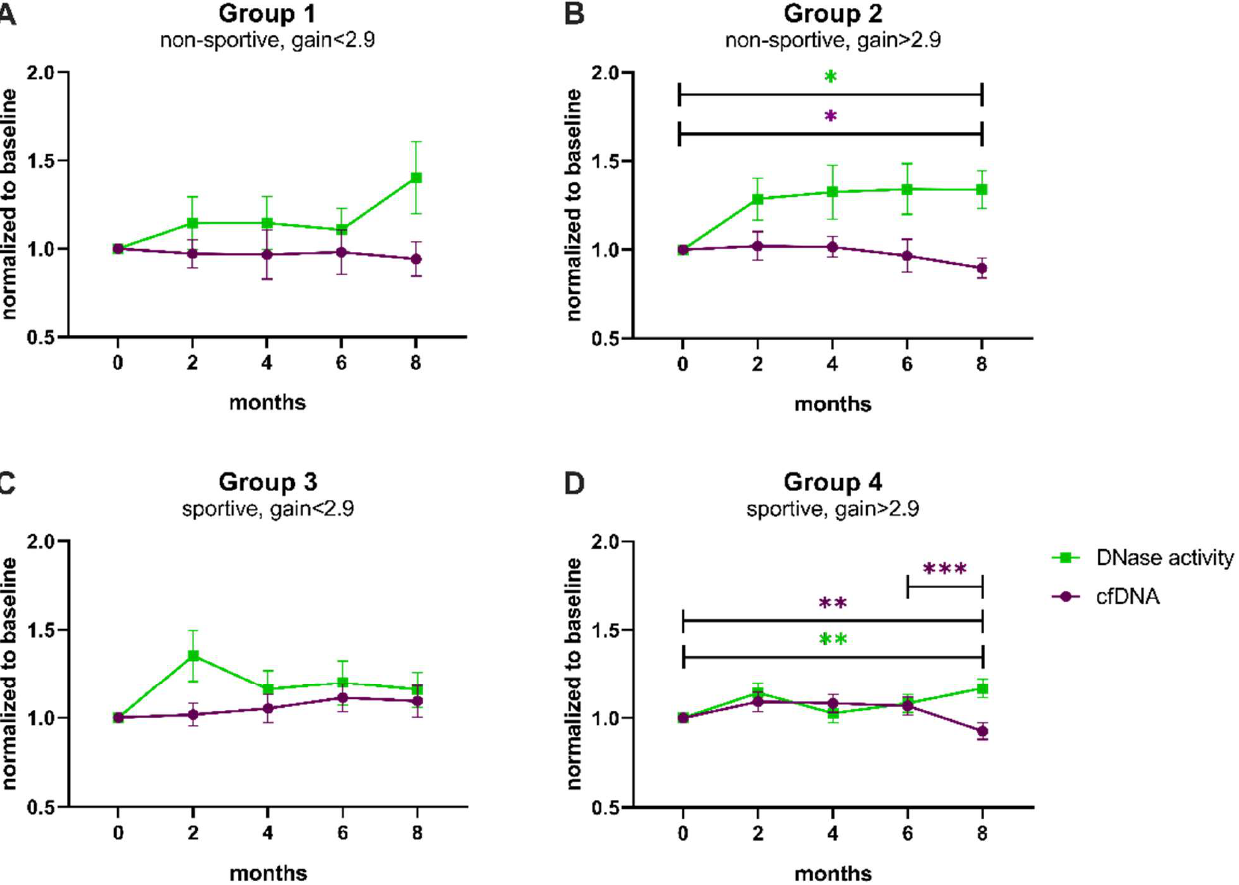
Figure 4. Trends of cfDNA levels and DNase activity normalized to baseline according to performance categories. ( A ) Non-sportive, gain < 2.9, ( B ) non-sportive, gain > 2.9, ( C ) sportive, gain < 2.9, ( D ) sportive, gain > 2.9. cfDNA levels (magenta) and DNase activity (green) were compared between baseline and 2 months, baseline and 8 months, and 6 and 8 months by paired t -tests, which were corrected using the Bonferroni–Holm method (Tables A2 and A3). Data are presented as mean ± SEM. * p < 0.05, ** p < 0.01, *** p < 0.001, SEM standard error of the mean.